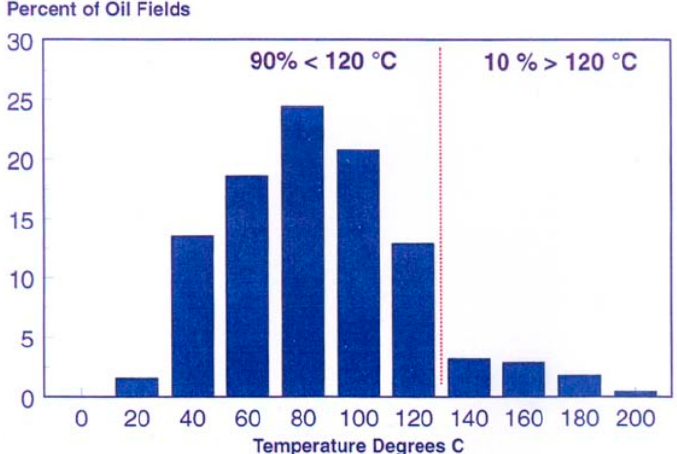
Figure 5. Temperature distribution of global oil fields (as of 1998) (reproduced from Bjorkum and Nadeau [100] with permission from CSIRO Publishing).